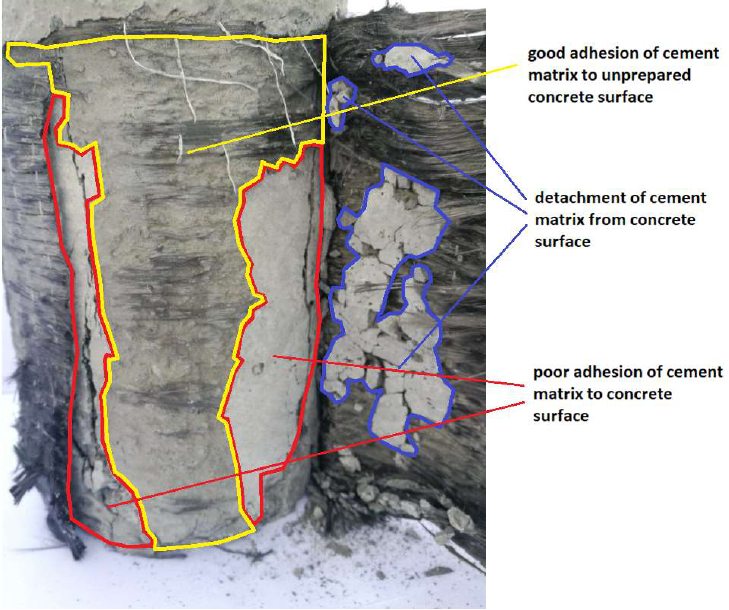
Figure 10. Analysis of the failure of the connection between the carbon fiber reinforced with the cement matrix and the unprepared concrete surface.